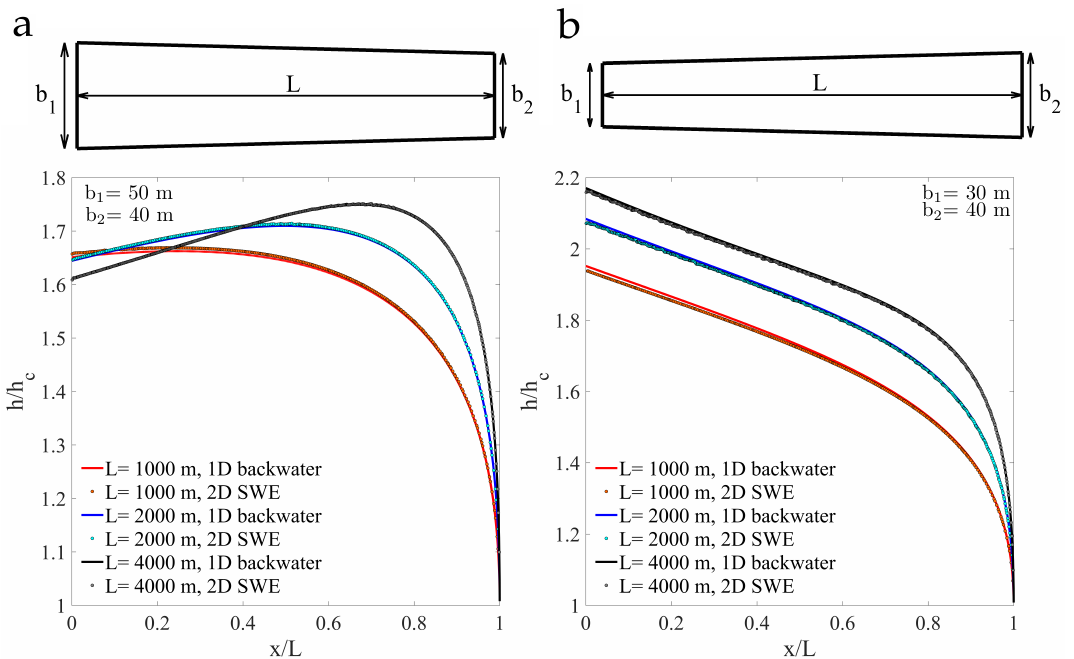
Figure 2. Model verification for subcritical flow in converging ( a ) and expanding ( b ) channels. The channel slope is S = 0.002, the total discharge is Q = 500 m 3 /s and Manning’s friction coefficient is n = 0.04. The boundary conditions in the 2D model are consistent with mild slope and subcritical flow: known total discharge, Q , at the upstream left boundary, and critical flow at the downstream right boundary. For the 1D theory we simply integrate (1)–(2) backwards with final condition h ( L ) = h c . We observe a very good agreement between the 1D and 2D